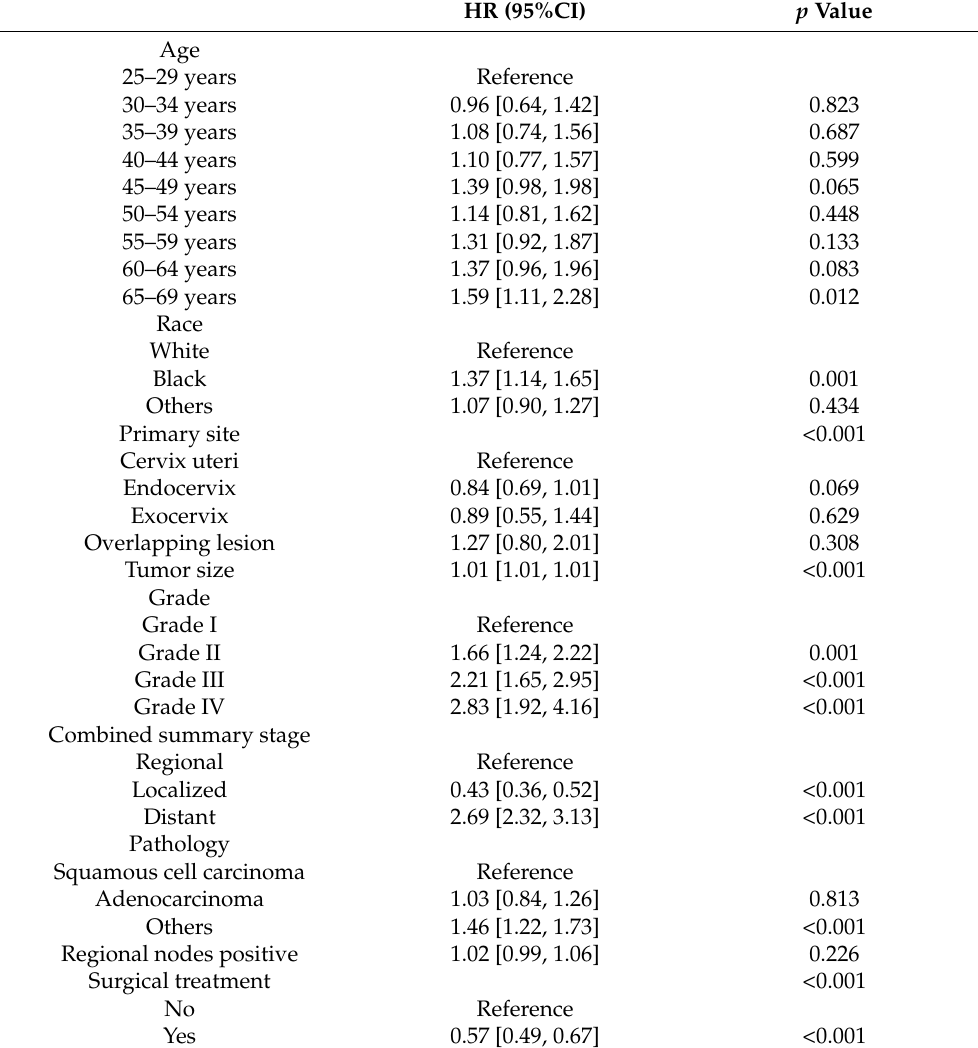
Table 2. Cox regression on the predictive factors for survival of patients with cervical